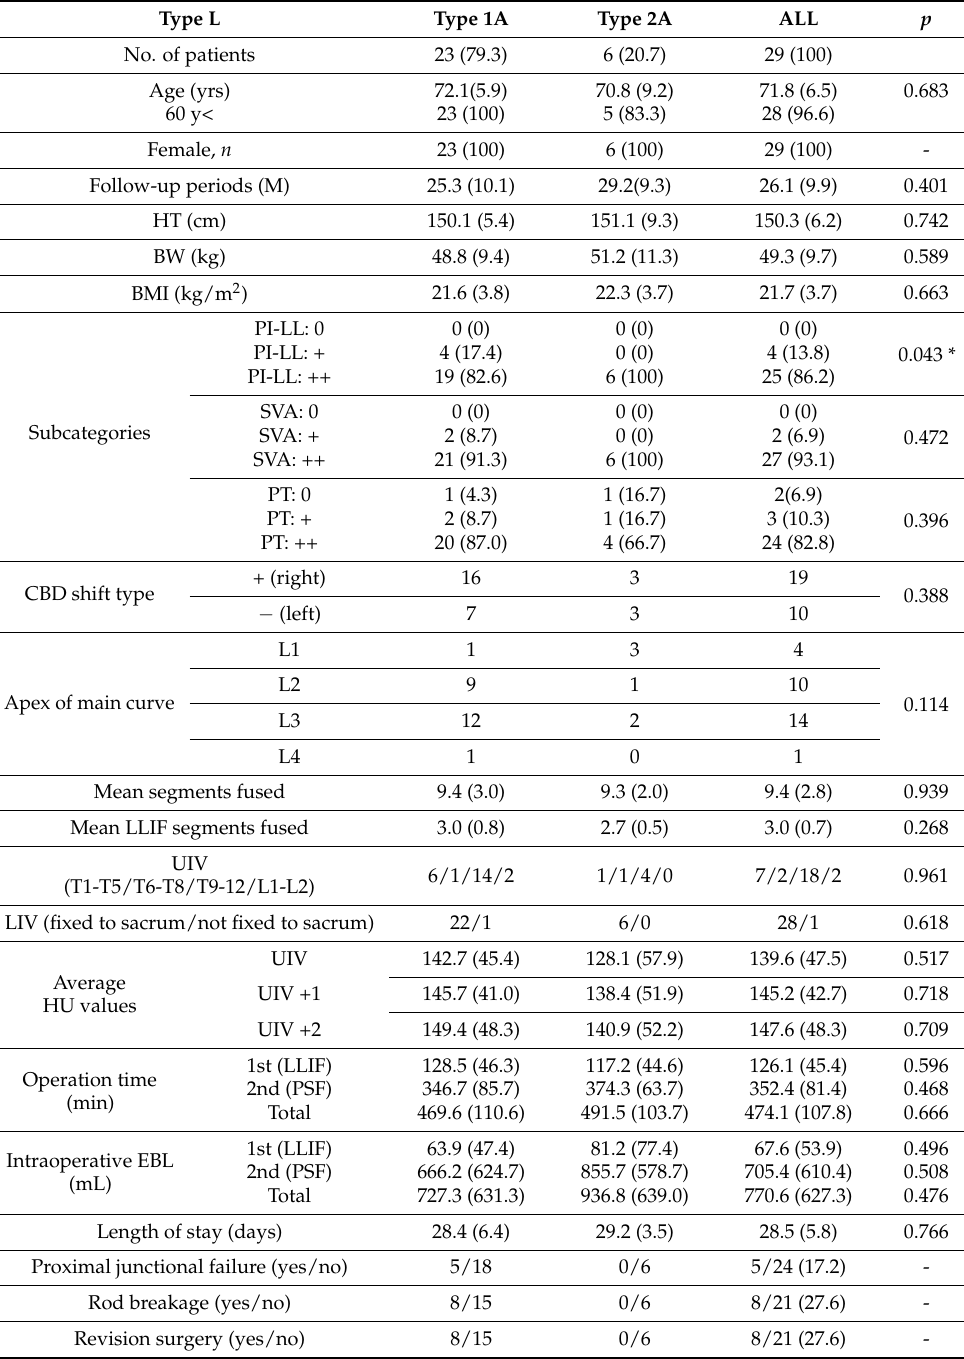
Table 2. Demographics of the two groups. Data presented as mean (SD) or number of patients (%). CBD, coronal balance distance, HT, height; BW, body weight; BMI, body mass index; LLIF, lateral lumbar interbody fusion; PSF, posterior spine fusion; EBL, estimated blood loss; SVA, sagittal vertical axis; PT, pelvic tilt; PI, pelvic incidence; LL, lumbar lordosis; UIV, upper instrumented vertebra; LIV, lower instrumented vertebra; HU, Hounsfield units. * Statistically